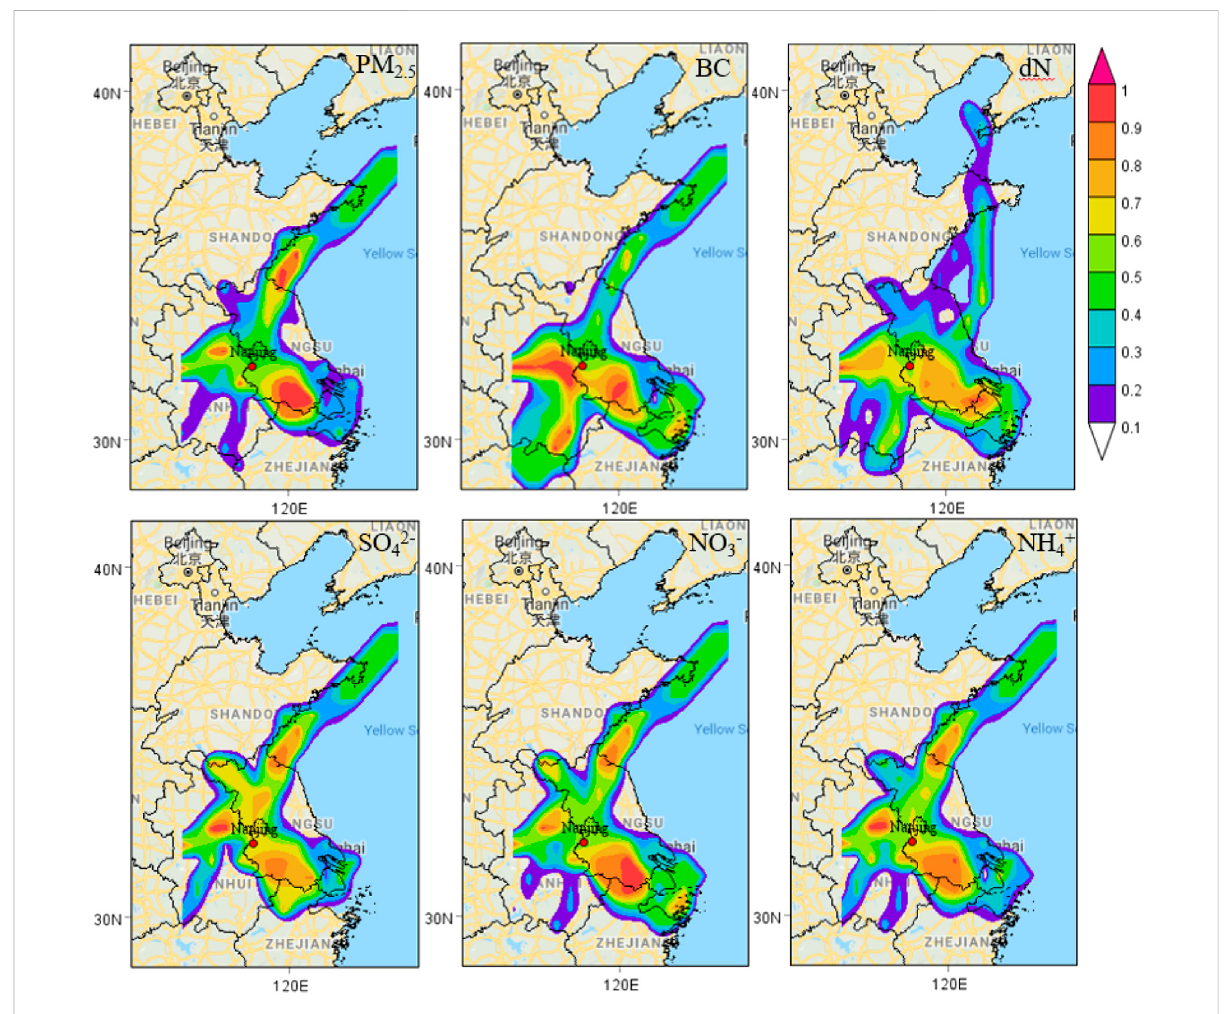
FIGURE 5 The PSCF analysis of major pollutants with backward